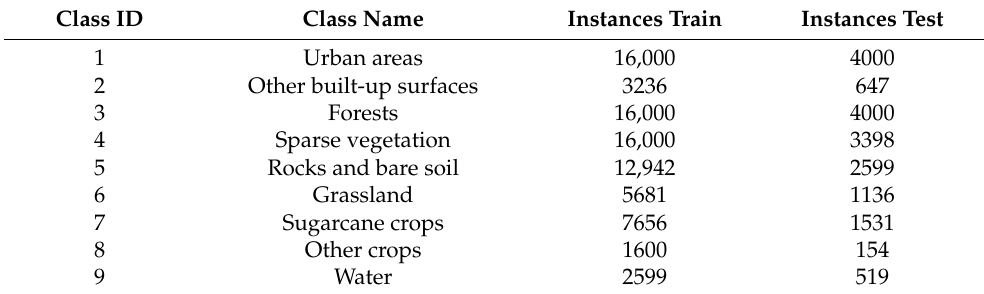
Table 1. Overview of class distributions in the training and testing datasets for the TiSeLaC dataset.